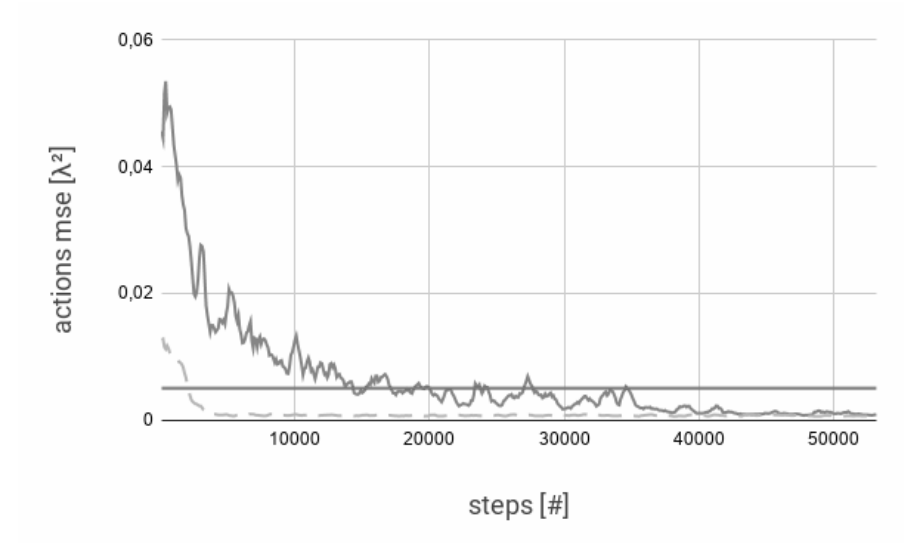
Figure 5. Accuracy of actions at predicting ground truth piston discontinuities. Capture range of [ − λ + λ ] in continuous line and [ − λ + λ ] in dashed line. The RL agent does not predict 0 /2, 0 /2 0 /4, 0 /4 the mse value itself, rather it learns how to minimize it through the optimization of the PSF. A horizontal line at rms = 50nm has been drawn. A system with an rms below that threshold is known to have a Strehl ratio of 0.8 for the given